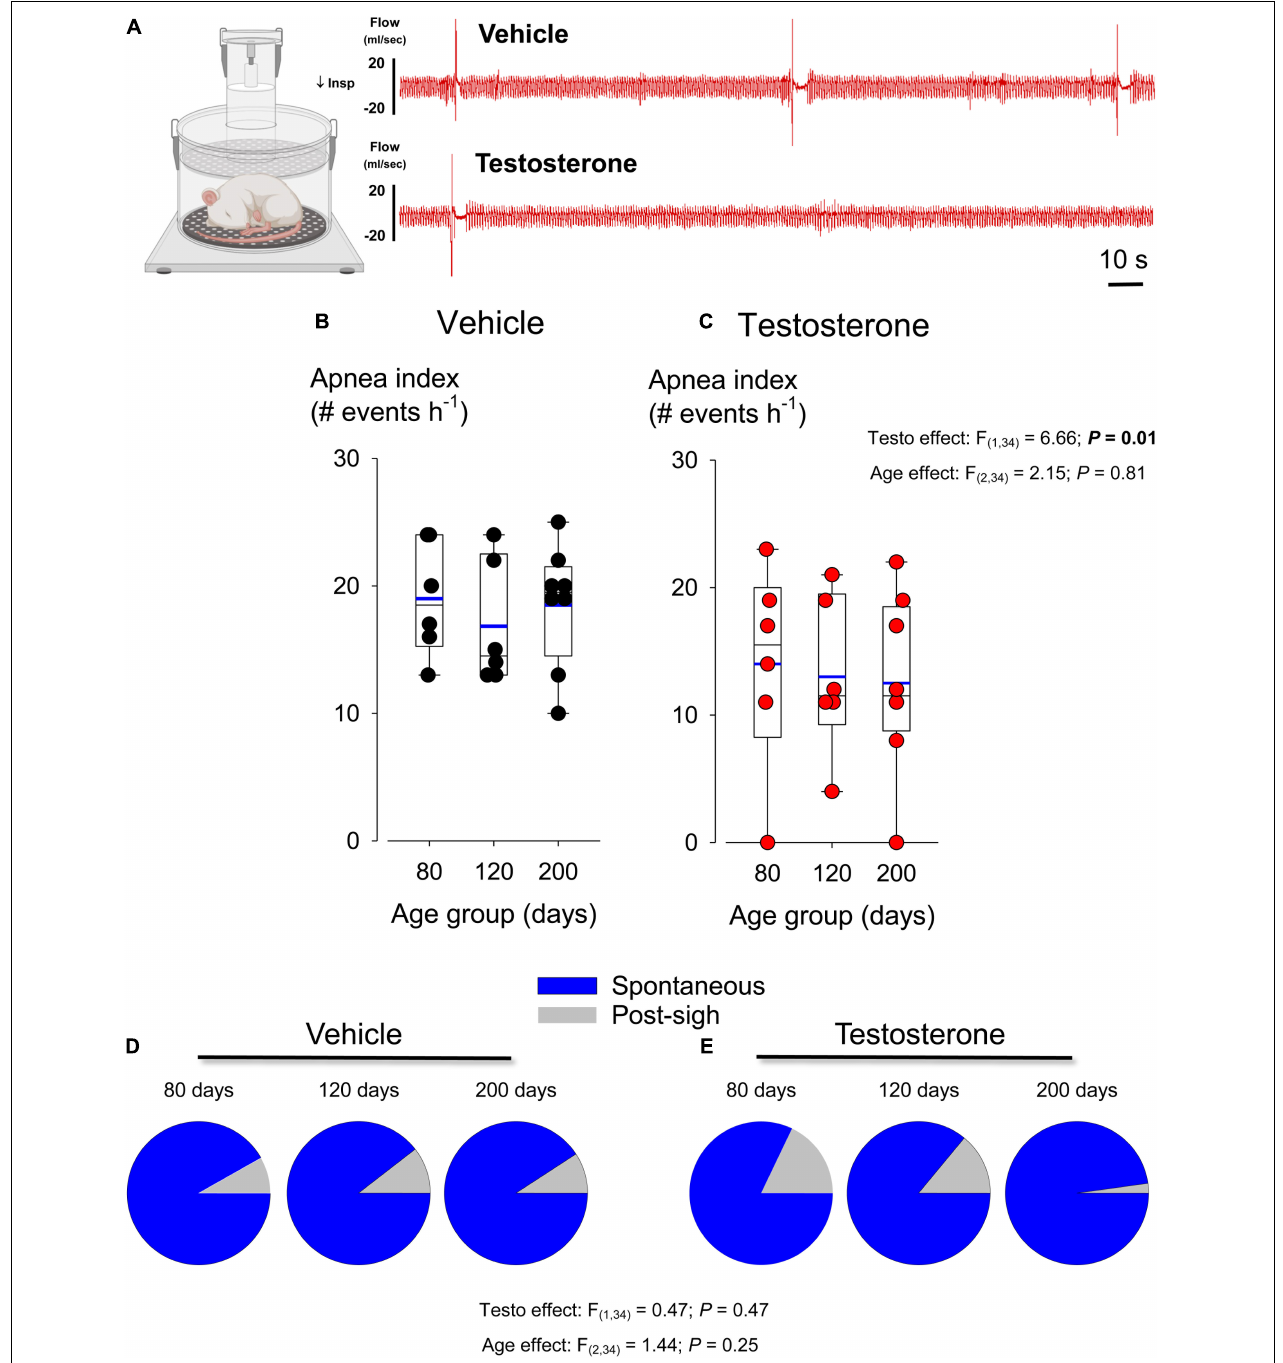
FIGURE 6 | Testosterone supplementation reduces apneas during sleep. (A) Comparison of plethysmography recordings obtained from adult rats (80 days old) that either received an intraperitoneal injection of vehicle (top trace; benzyl benzoate + alcohol benzoate dissolved in cottonseed oil) or testosterone propionate (lower trace; 2 mg/kg; i.p.) 30 min prior to the onset of the experiment. Sleep/wake states was assessed according to the stability of the respiratory signal as described by Bastianini et al. (2017). (B) Box plots comparing the apnea index of vehicle-treated rats at three distinct age groups: 80, 120, and 200 days old. (C) Similar comparison in testosterone-treated rats. The apnea index is defined as the number of apneic events per hour of sleep. In each box plot, the boundary of the box closest to zero indicates the 25th percentile, the line within the box marks the median, and the boundary of the box farthest from zero indicates the 75th percentile. Whiskers (error bars) above and below the box indicate the 90th and 10th percentiles. (D) Pie charts comparing the proportion of spontaneous (blue) and post-sigh (gray) apneas measured in vehicle-treated rats at 80, 120, and 200 days of age. (E) Similar comparison in testosterone-treated rats. See section “Materials and Methods” for the details on the criteria used to identify apnea